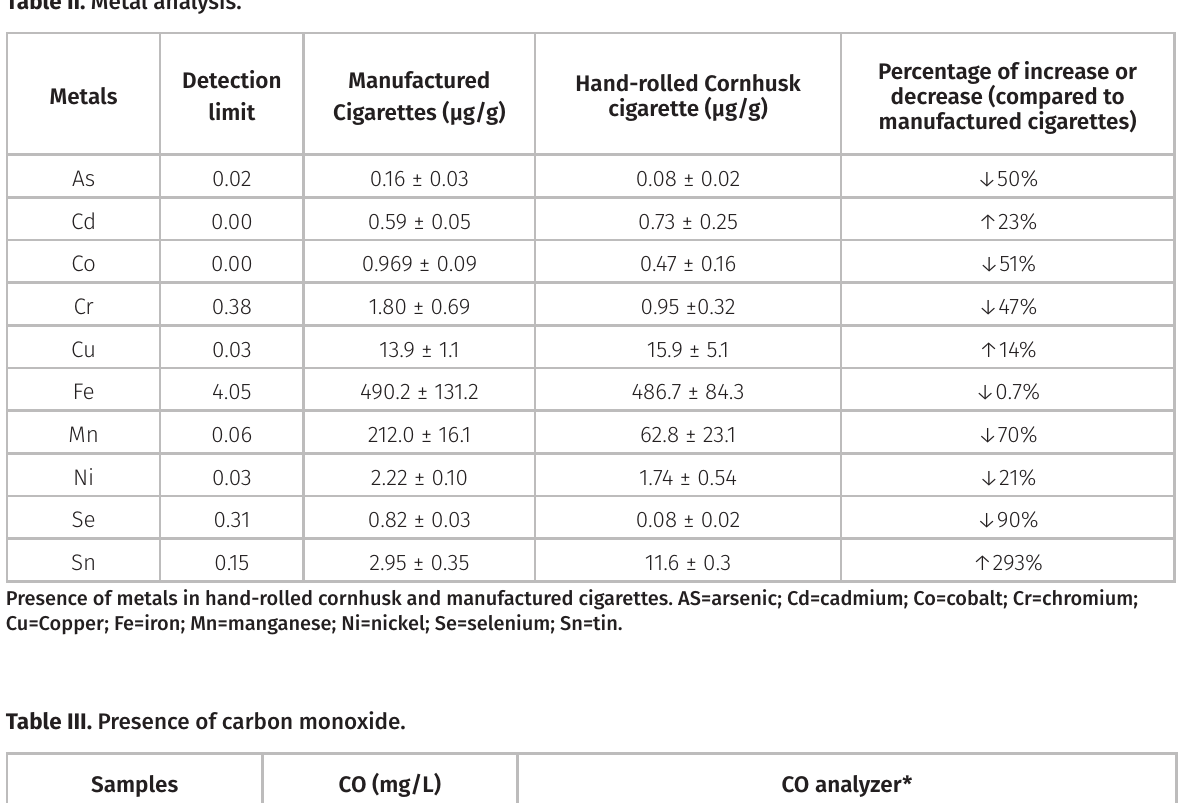
Table II. Metal analysis.